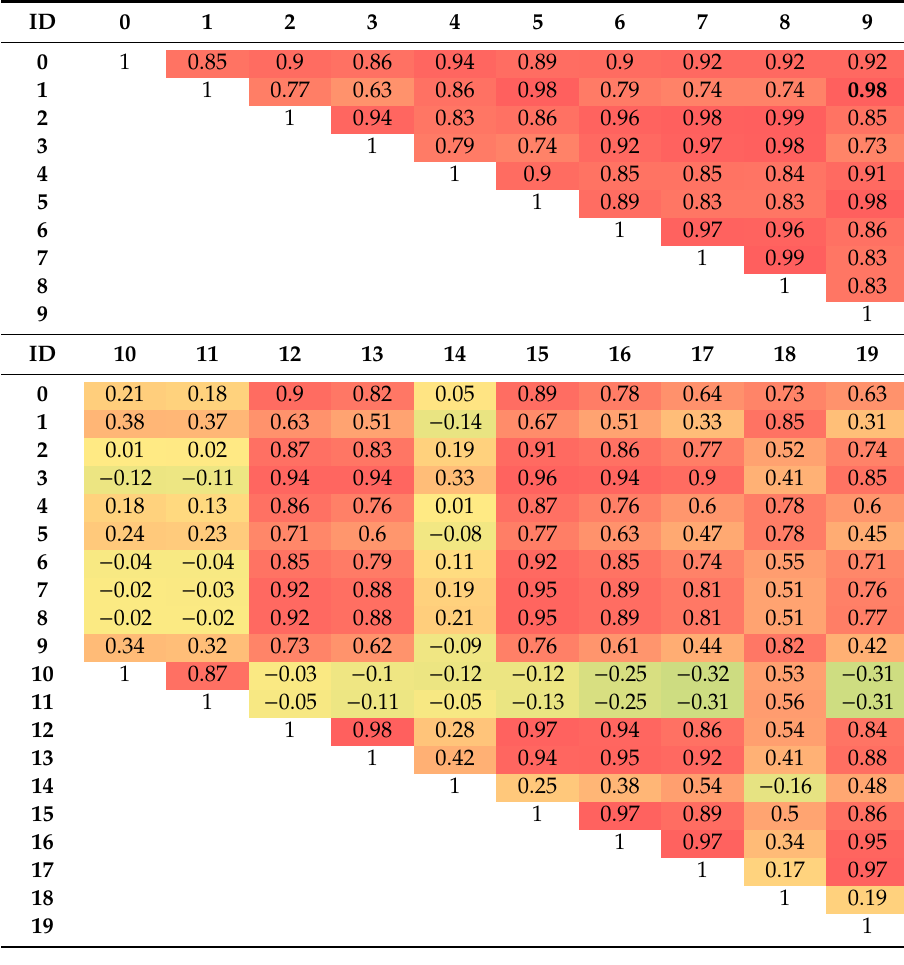
Table 1. Correlation table at study points around the Salish Sea from the H11